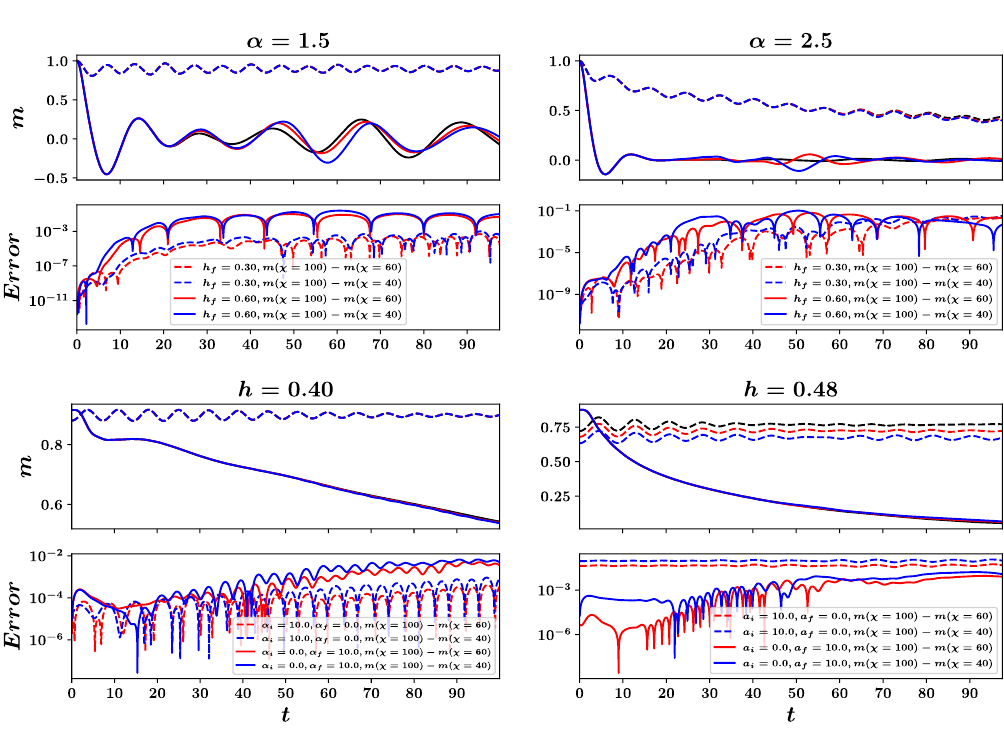
Figure 11: Convergence of subsystem magnetization and relative errors with increas- ing bond dimension, χ = 40 (blue), χ = 60 (red), and χ = 100 (black). The top = 0.30(colored dotted) , and h = 0.60(colored row is for α = { 1.5,2.5 } and h f f bold). The bottom row is for h = { 0.40,0.48 } and quench from α = 10.0 to α = 0.0 (colored dotted) α = 0.0 to α = 10.0 (colored bold)